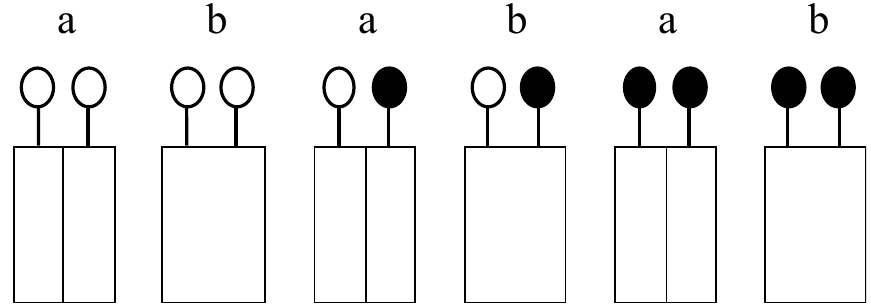
Figure 8. Schematic representation of the plant arrangement in sole crops and intercrops to give Aerial ( a ) and Full row contacts ( b ). Triticale (o); field bean ( • ). For the experiment, 40 stainless-steel boxes with 1.0 m length, 0.2 m width, and 0.45 m depth, with large removable sides, were filled with 80 dm 3 of soil. The physical and chemical properties of the soil were: 69.1% sand, 26.6% silt, and 4.3% clay (USDA method); pH 8.2 (soil:H 2 O 1:2.5), organic matter 17.3 g kg − 1 (Walkley and Black method), total CaCO 3 5.4 g kg − 1 , total N 1.3 g kg − 1 (Kjeldhal